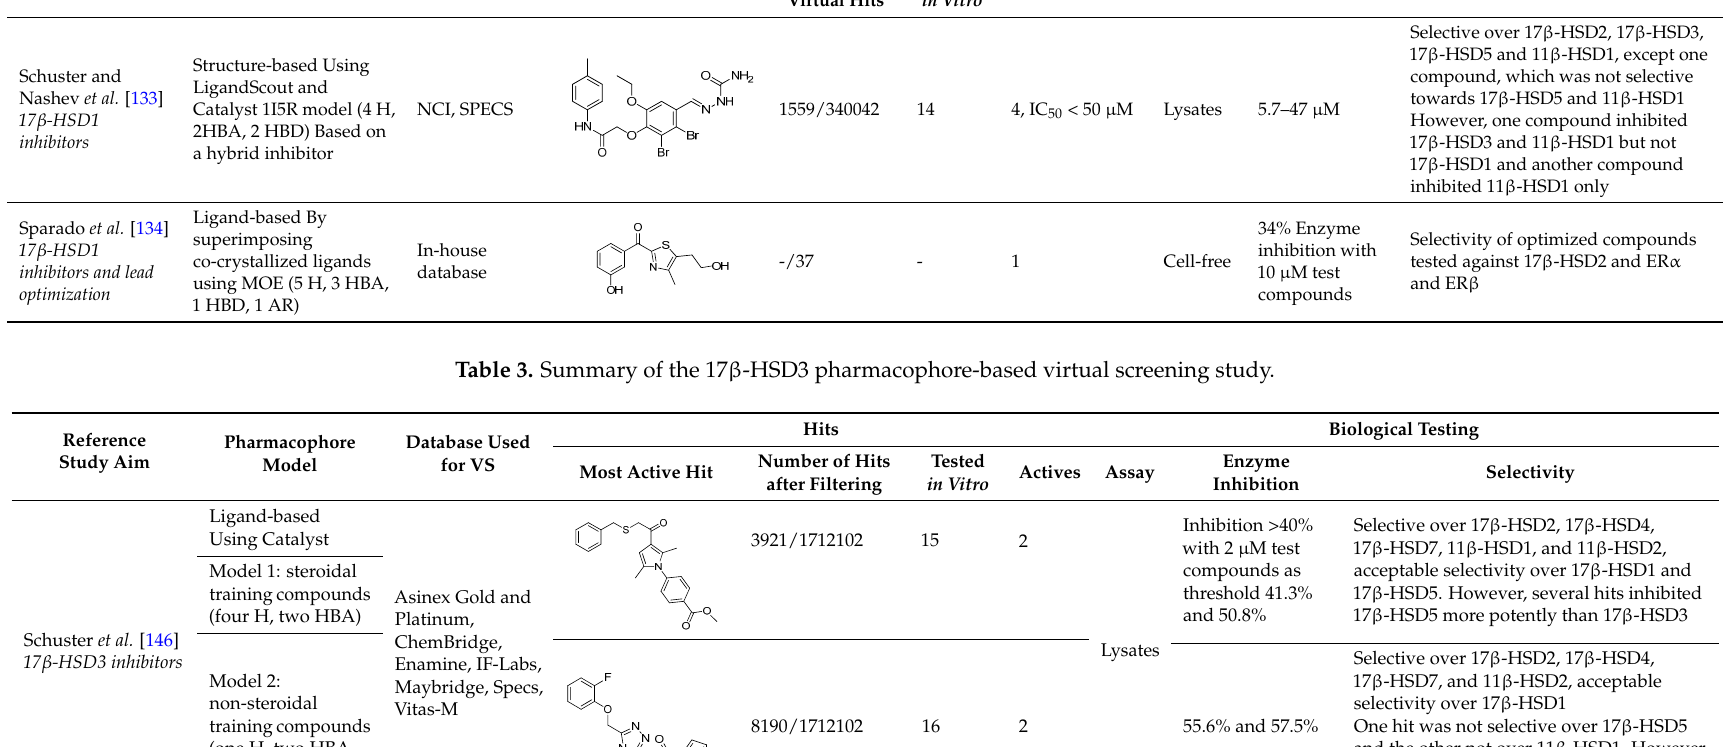
Table 2. 17 β -HSD1 pharmacophore-based virtual screening studies summarized.